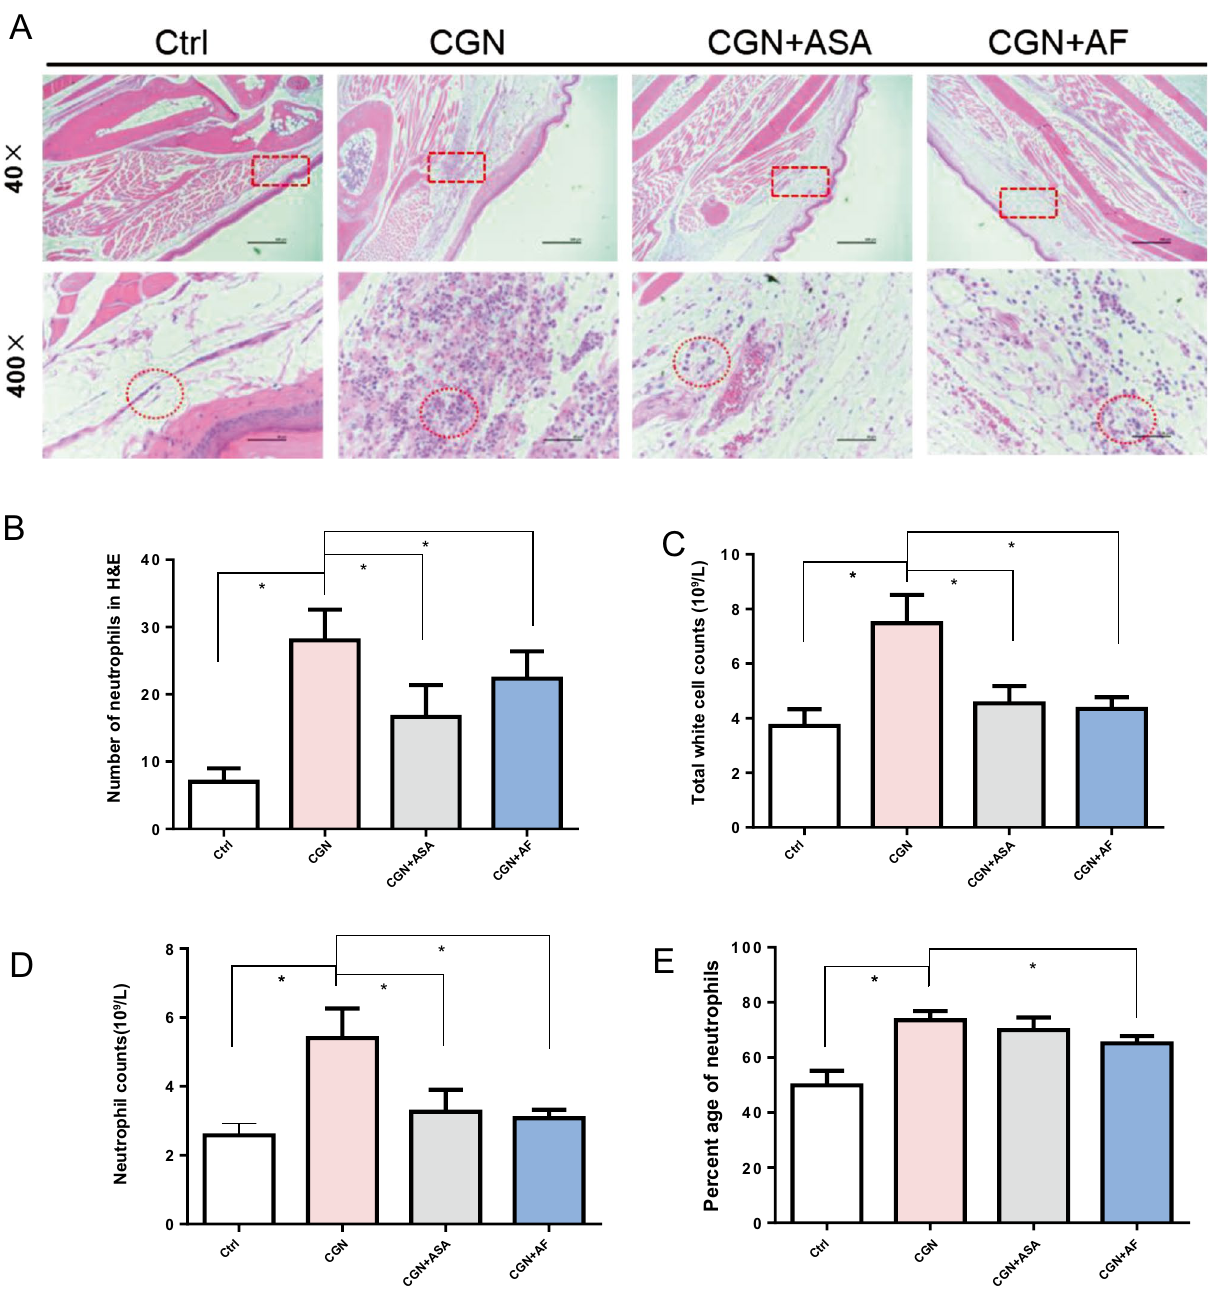
Figure 2. Histopathological examination and assessment of cell counting. ( A ) Histopathological microphotography under microscope with the magnification of 40 × and 400 ×. ( B ) The neutrophils at the position of paw edema were circled with equal-area red dotted lines and was the average number of neutrophils quantified by image J at the magnification of 400 ×. ( C ) Total white cell counts in λ-carrageenan mice blood assessed with hemocytometer. ( D ) The number of neutrophiles. ( E ) The percentage of neutrophils. Numerical data are presented as mean ± SEM (n = 5). * P < 0.05 were considered as significant difference compared to the control